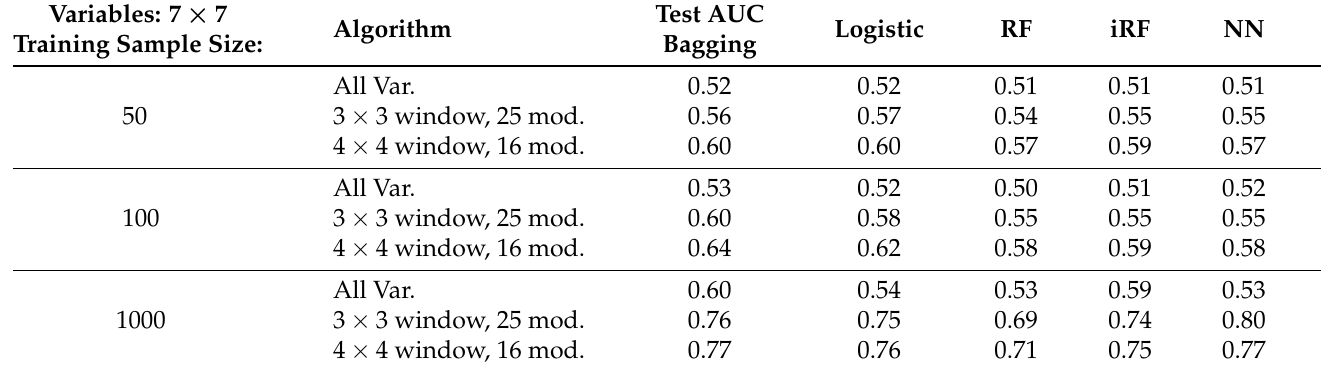
Table 6. Simulation results for Model (12). The theoretical prediction rate was calculated using Equation (13) as 75%. In other words, we expected prediction performance on th out-of-sample test set to be approximately 75% on average. For each experiment below, the out-of-sample test set had 1000 sample data points and the performance was calculated using the area under the curve (AUC) from the receiver operating characteristic (ROC). For each experiment, we changed the in-sample training size to be 50, 100, or 1000, and we fixed all data to have 49 variables. For each pair of in-sample training size and number of variables, we ran experiments using all original variables, i.e., “All Var.”, with a variety of different classifiers. Alternatively, we used the proposed method to construct new variable modules, which were used as new features on the same classifier. The table shows that the proposed method provides improved prediction performance regardless of sample size or classifier